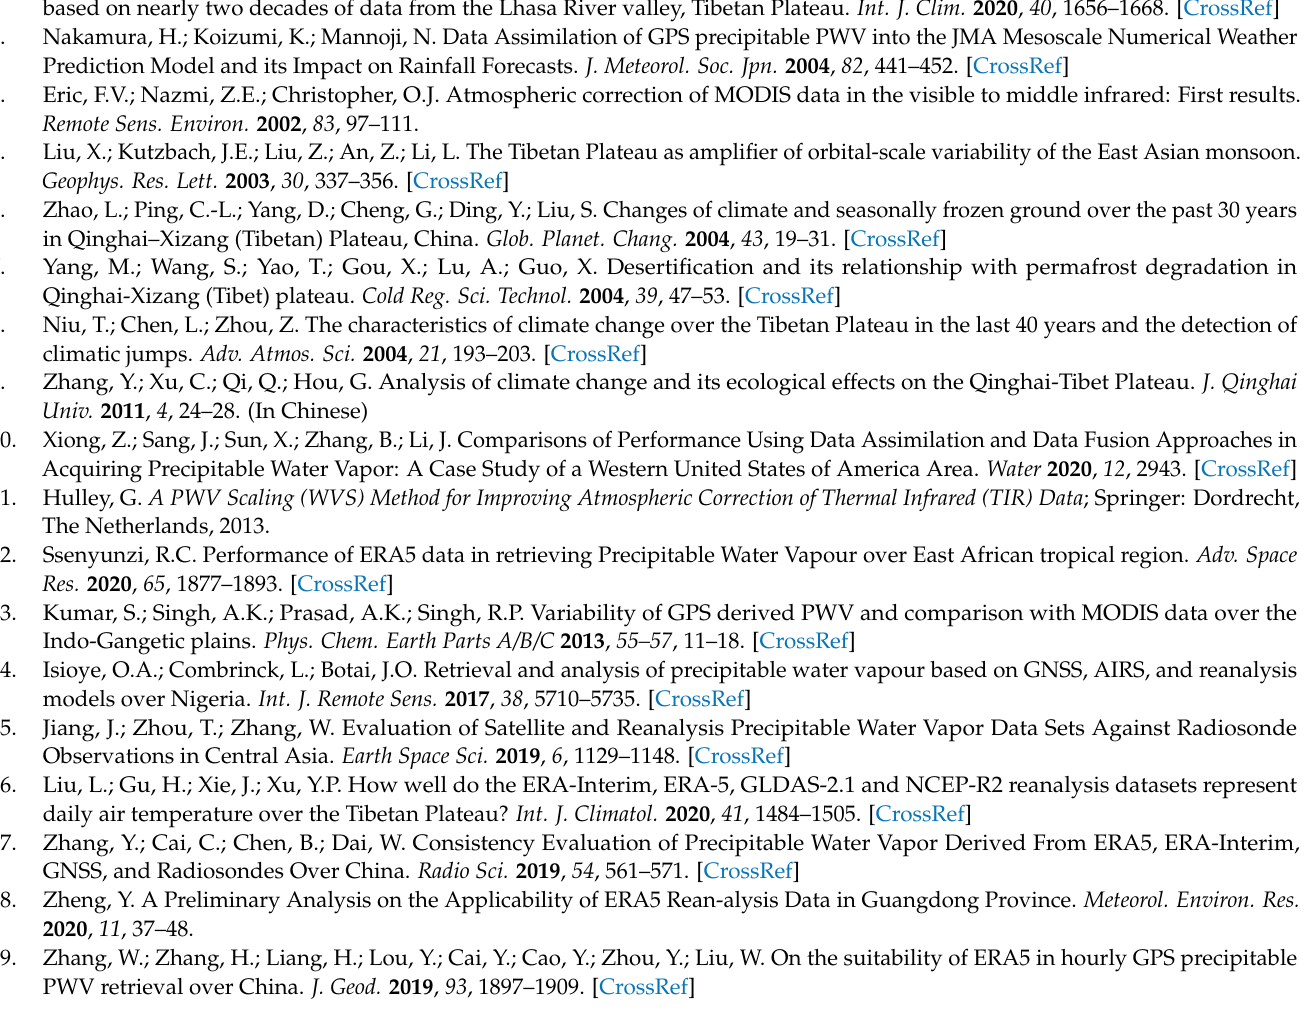
Figure A5. Change trend of the monthly moving average of radiosonde and ERA-5 temperature at 500 hPa at different stations. ( a ) Golmud station, ( b ) Dulan station, ( c ) Xining station, ( d ) Yushu station.